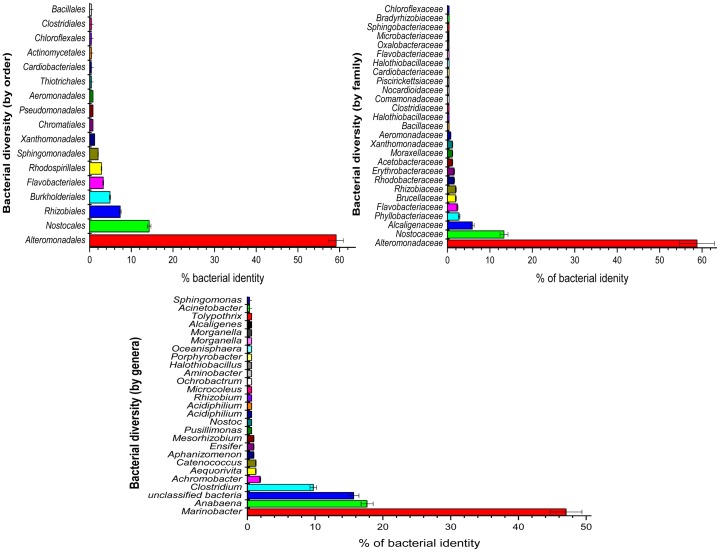
Composition of the bacterial orders, family and genera detected in the mine water with sequences of the variable region V1–3 of the 16S rRNA genes.